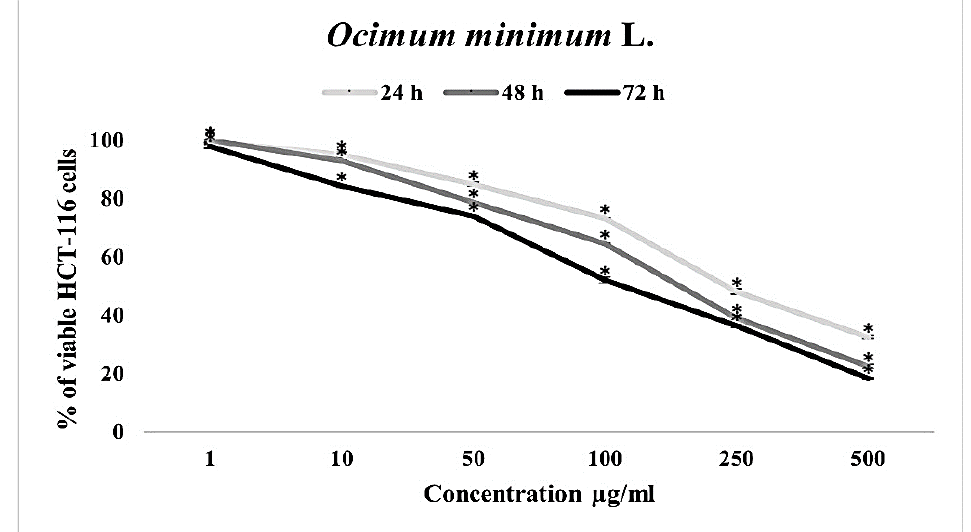
Figure 1. Antiproliferative effects of O. minimum on HCT-116 colorectal carcinoma cells. The results are presented as the mean of two independent experiments ± standard error. * Statistically significant difference (p<0.05) in relation to control